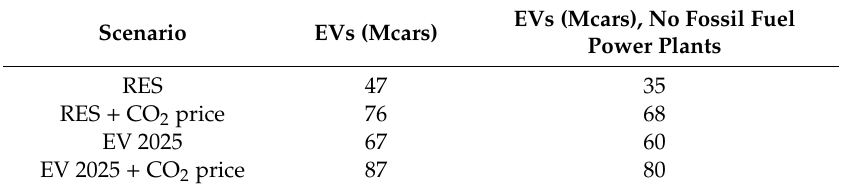
Table 8. Overall EV fleet composition (million cars) in scenarios with and without fossil fuel power plants.